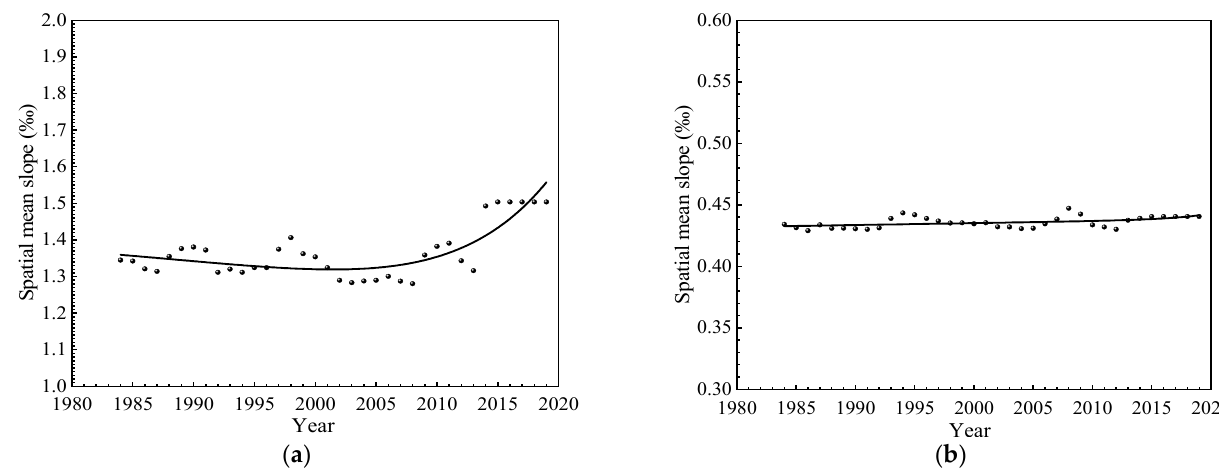
Figure 13. ( a ) The temporal distribution of intertidal zone slope in the north erosion part; ( b ) The temporal distribution of intertidal zone slope in the south deposition part.